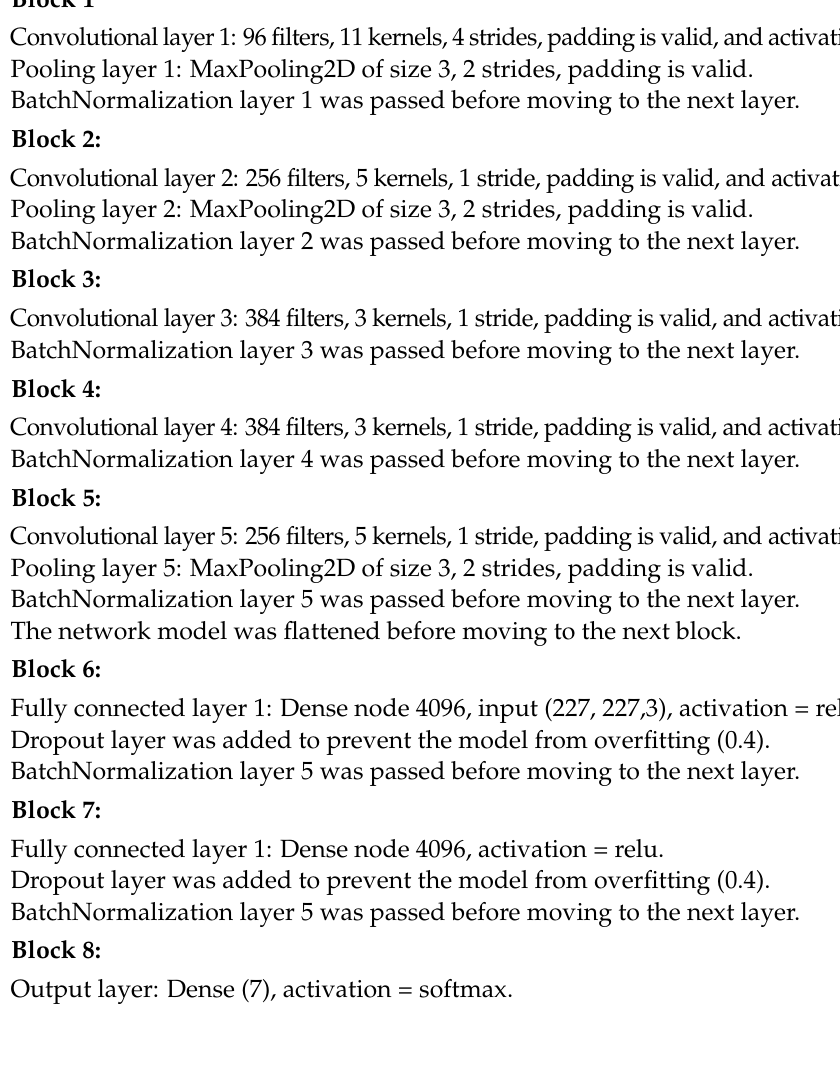
Figure 3. Modified AlexNet Architecture for Human Posture Image Classification. Block